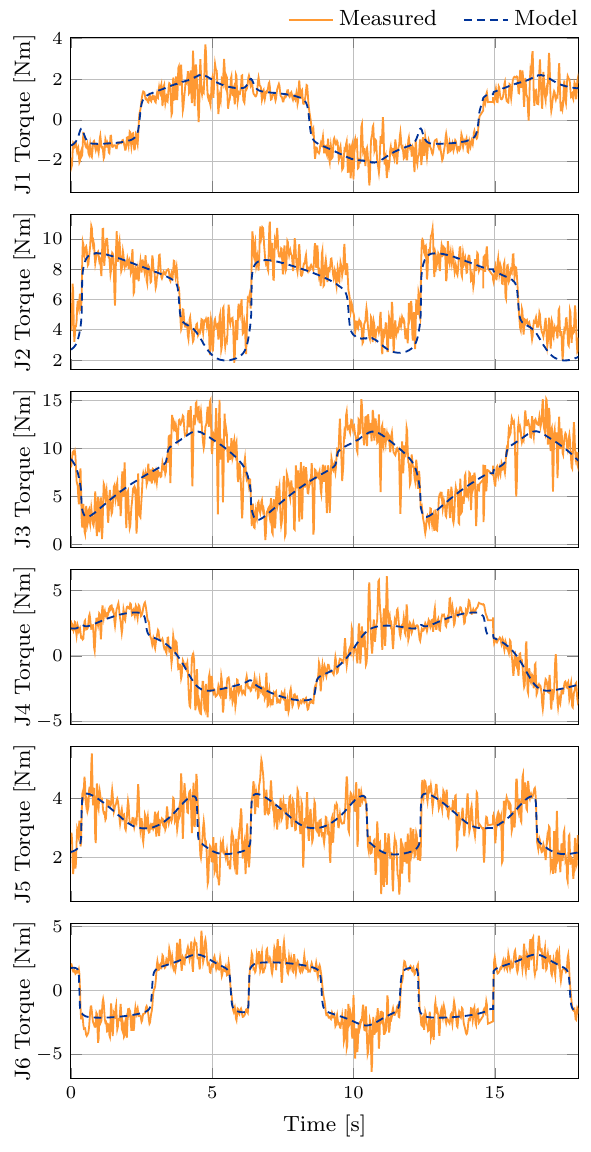
Fig. 10 Results from a validation experiment based on a Cartesian space trajectory; comparison of measured torques and torques computed by the model using the estimated parameters